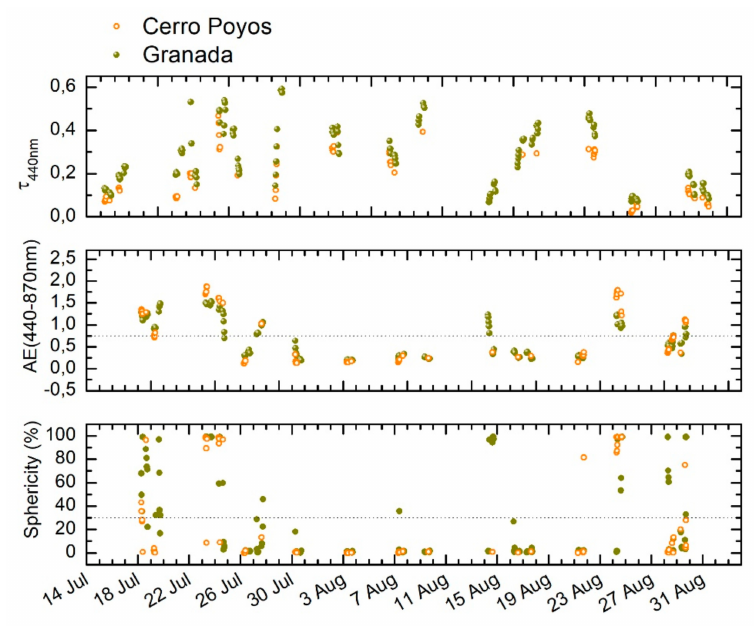
Figure 1. Aerosol Robotic Network (AERONET) retrieved τ 440 nm, AE (440–870 nm) and sphericity corresponding to the analysed days during summer